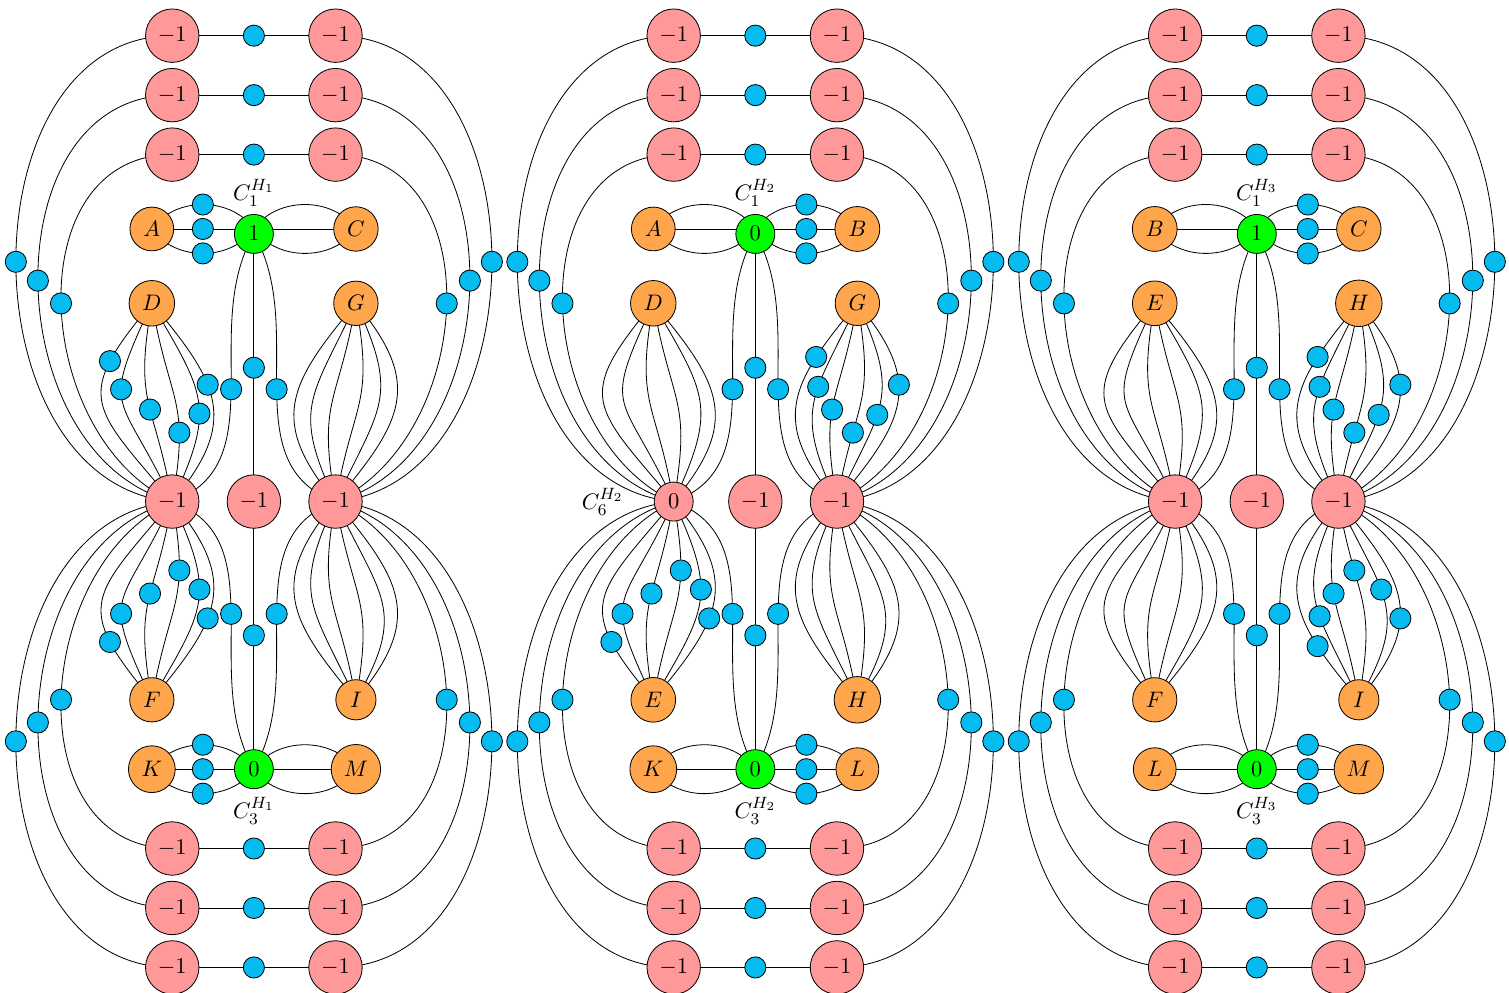
on C • encoded by figure 2. Exceptional P 1 s are indicated in blue and each carries a line bundle of degree ( 3 , 1 ) 1 / 3 ( 3 , 1 ) 1 / 3